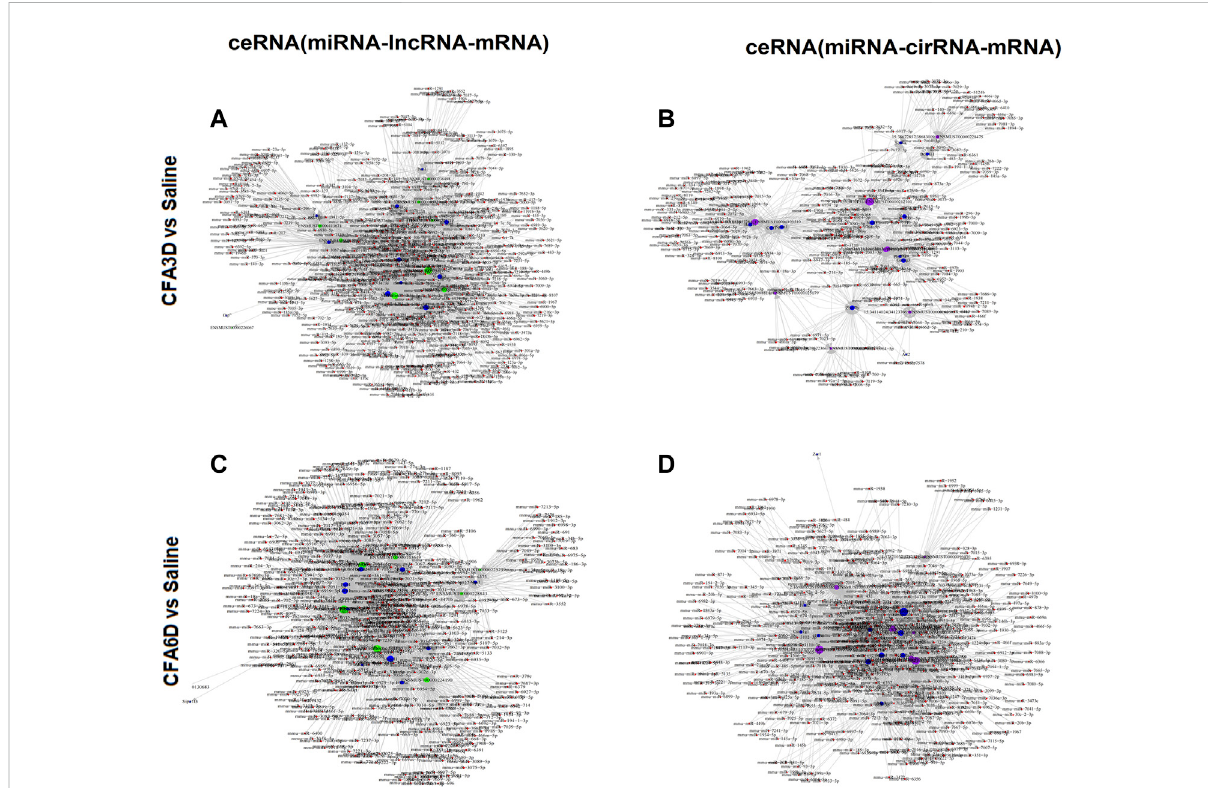
FIGURE 10 Potential interaction between miRNA – long noncoding RNA (lncRNA) – mRNA networks and miRNA – circular RNA (cirRNA) – mRNA networks in TG regions after temporomandibular joint disorders (TMD). The ceRNA networks were constructed based on the correlation analysis. Red nodes represent miRNAs, green nodes represent lncRNAs, purple nodes represent cirRNAs, and blue nodes represent mRNAs. The ceRNA regulatory network was constructed with the same direction of differential expression (generally positive correlation); otherwise, the ceRNA regulatory networkwasconstructedbetweenmultiplegroupsorrepeatedsamplesbasedonboth p value ≤ 0.05andPPC ≥ 0.5(generallypositivecorrelation).